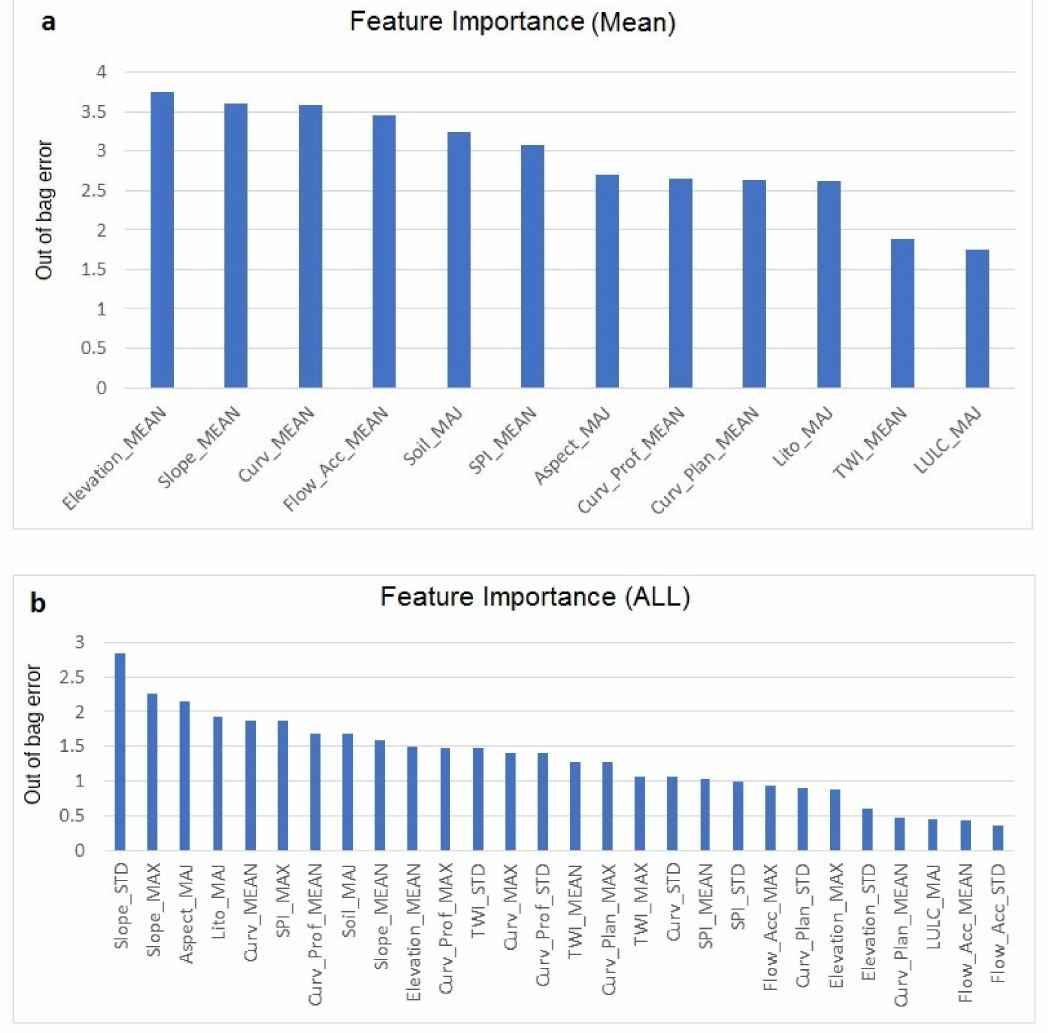
Figure 9. Ranking of the parameters used in the best performing configurations, according to their importance estimated by the out of bag error ( a ): using mean configuration and ( b ): using all parameters together). see Table 1 for details on the variables